Question: In a single sentence, describe what this figure presents.
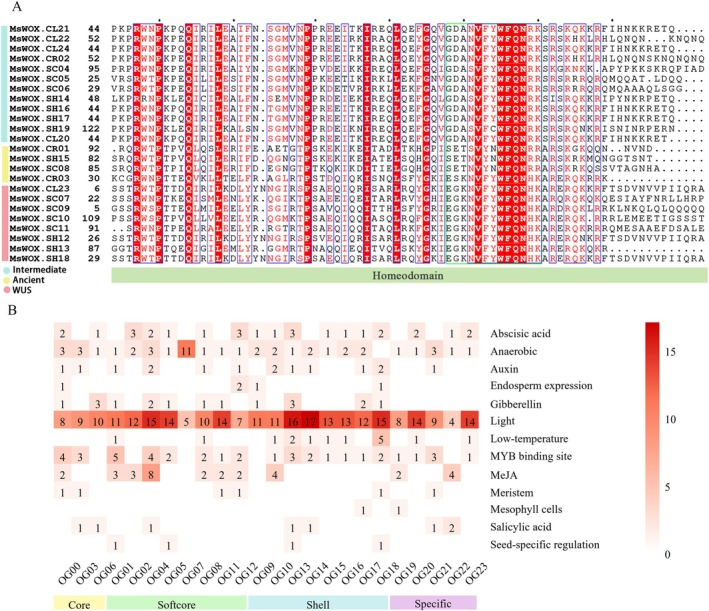
Answer: (A) Multiple sequence alignment of representative genes from different OGGs in alfalfa. (B) Average number of cis‐acting regulatory elements in representative genes from each OGG.